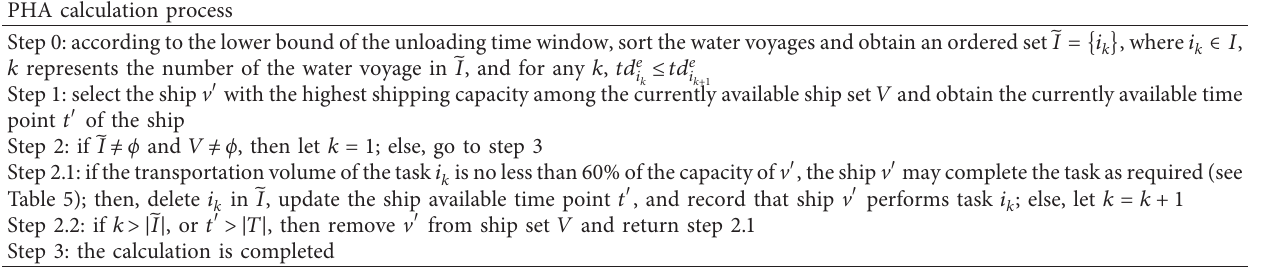
Table 4: A summary of the PHA calculation process.